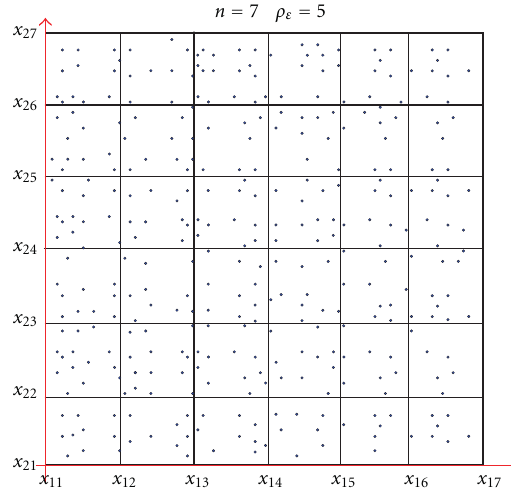
Figure 3: Example of correct uniform fuzzy partition